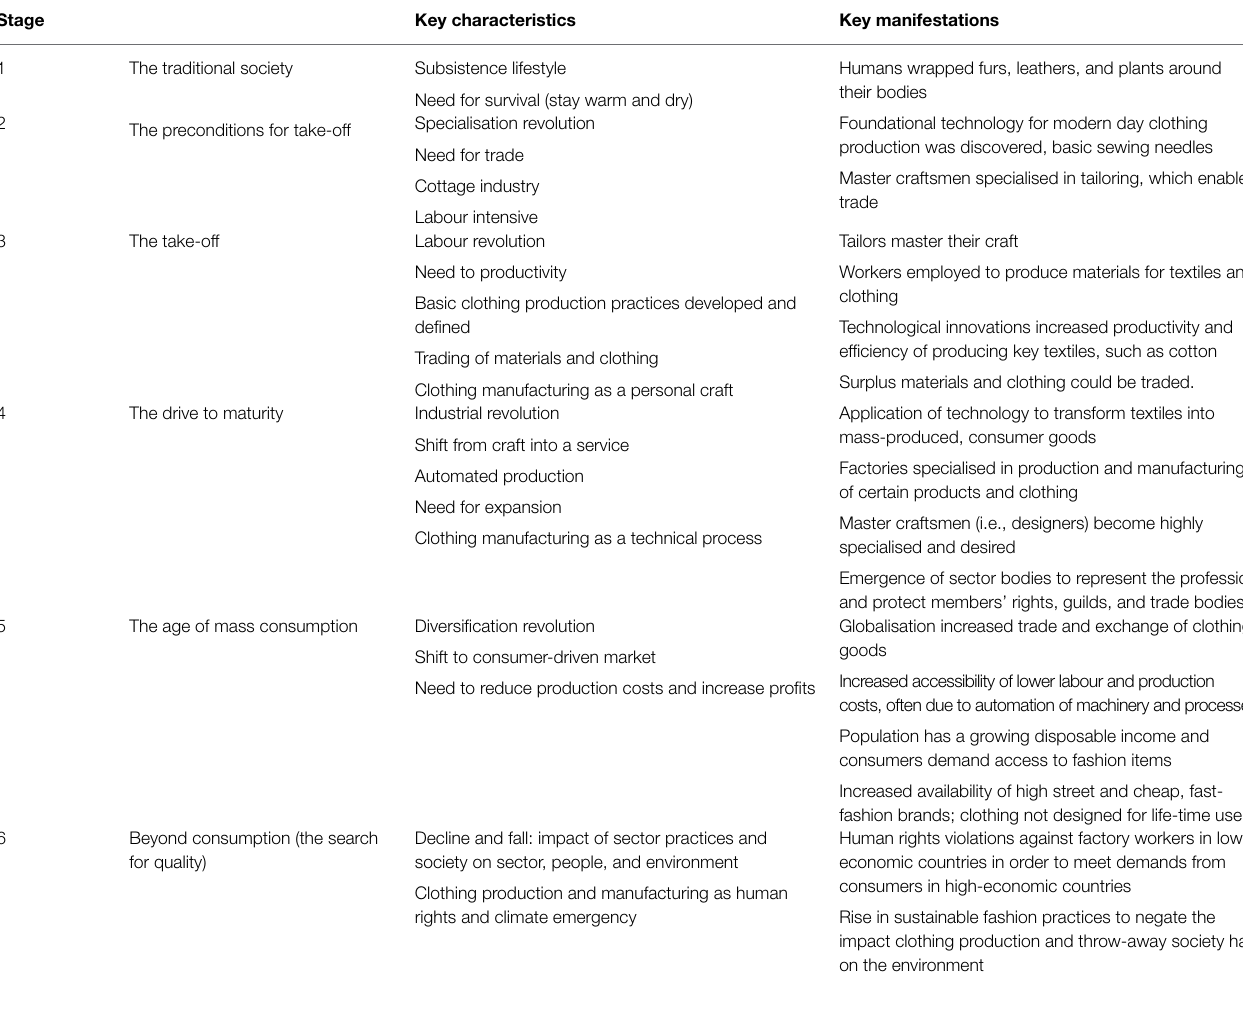
TABLE 2 | Model of clothing sector development based on Rostow’s